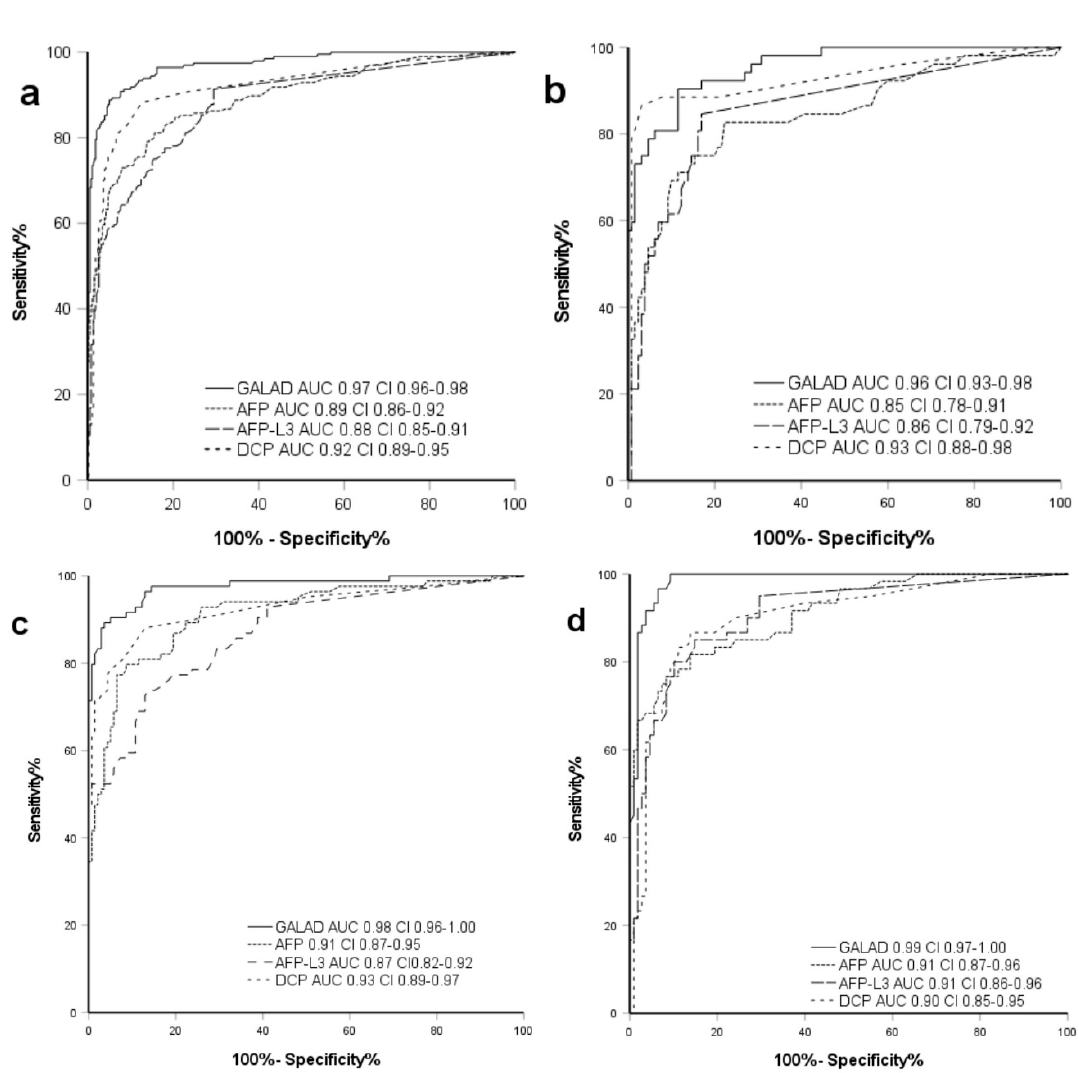
Figure 2. ROC-curve for GALAD vs. individual biomarkers in all etiologies. ROC-Curve for GALAD, AFP, AFP-L3 and DCP for HCC detection; ( a ) all patients, ( b ) HBV, ( c ) HCV, ( d ) others. DeLong test p -Value: All p -values ≤ 0.001. HCC: hepatocellular carcinoma, HBV: chronic hepatitis B infection, HCV: chronic hepatitis C infection, AFP: alpha-fetoprotein, AFP-L3: ratio of LCA-reactive AFP to total AFP, DCP: des-gamma-carboxyprothrombin, AUC: area under the curve, CI: confidence interval.